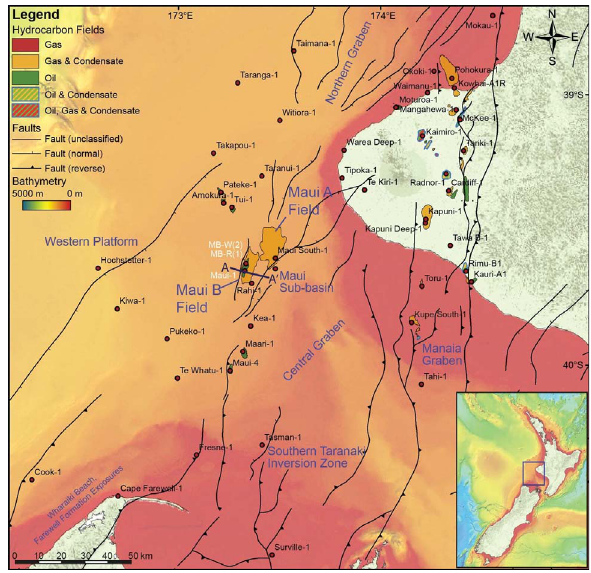
Figure 2. Map of central and southern Taranaki Basin with the Maui and Pohokura Fields indicated in